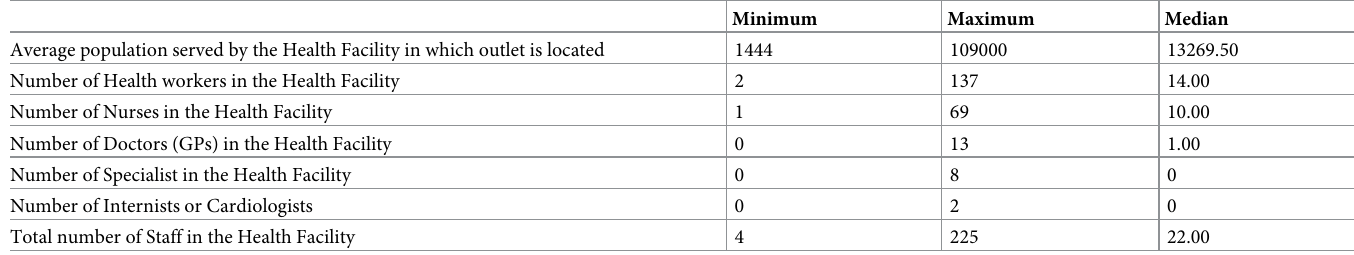
Table 1. Average population and personnel